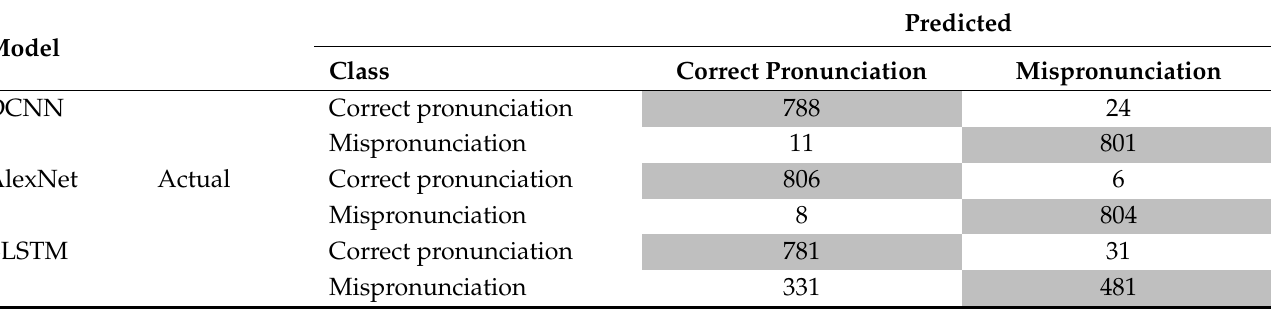
Table 11. DCNN without data